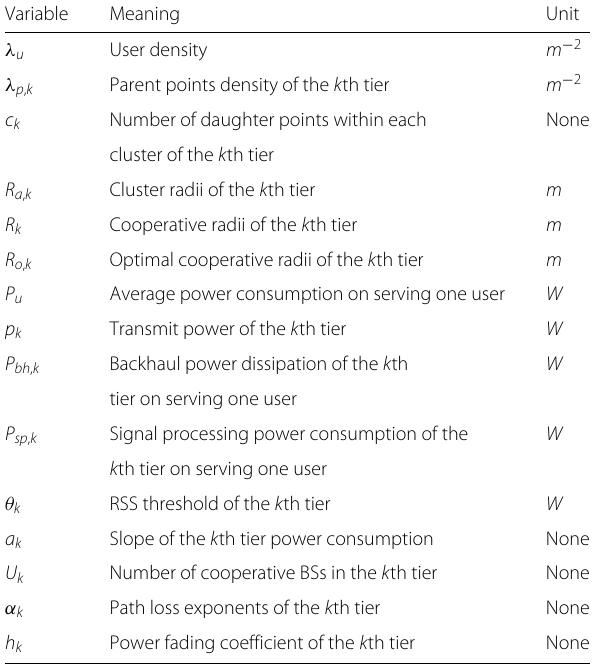
Table 1 Major symbols used in this